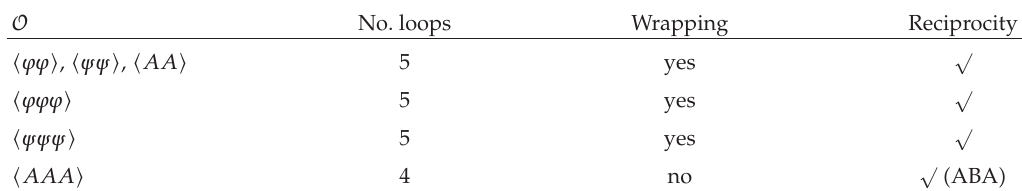
Table 1: Status of weak coupling reciprocity on minimal dimensions for twist operators. O No. loops